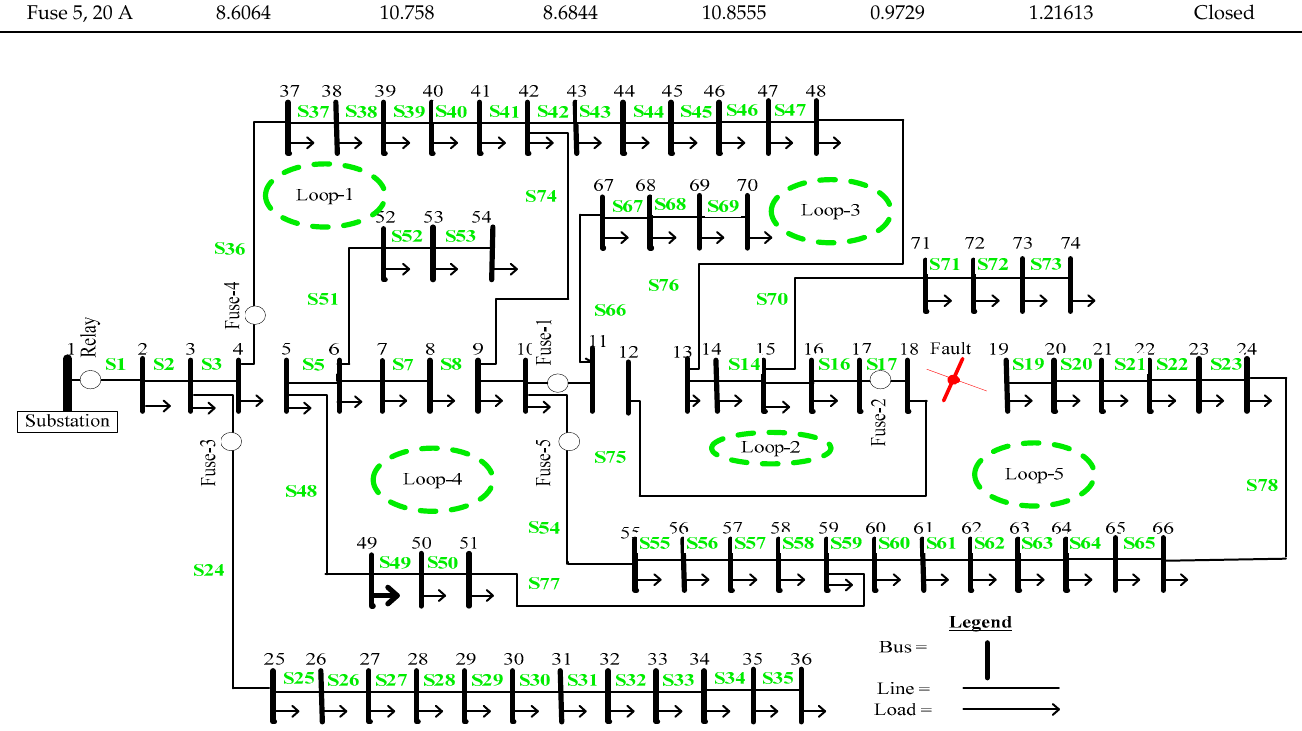
Figure 4. Restored network in single fault cases without protection constraints using TLBO.